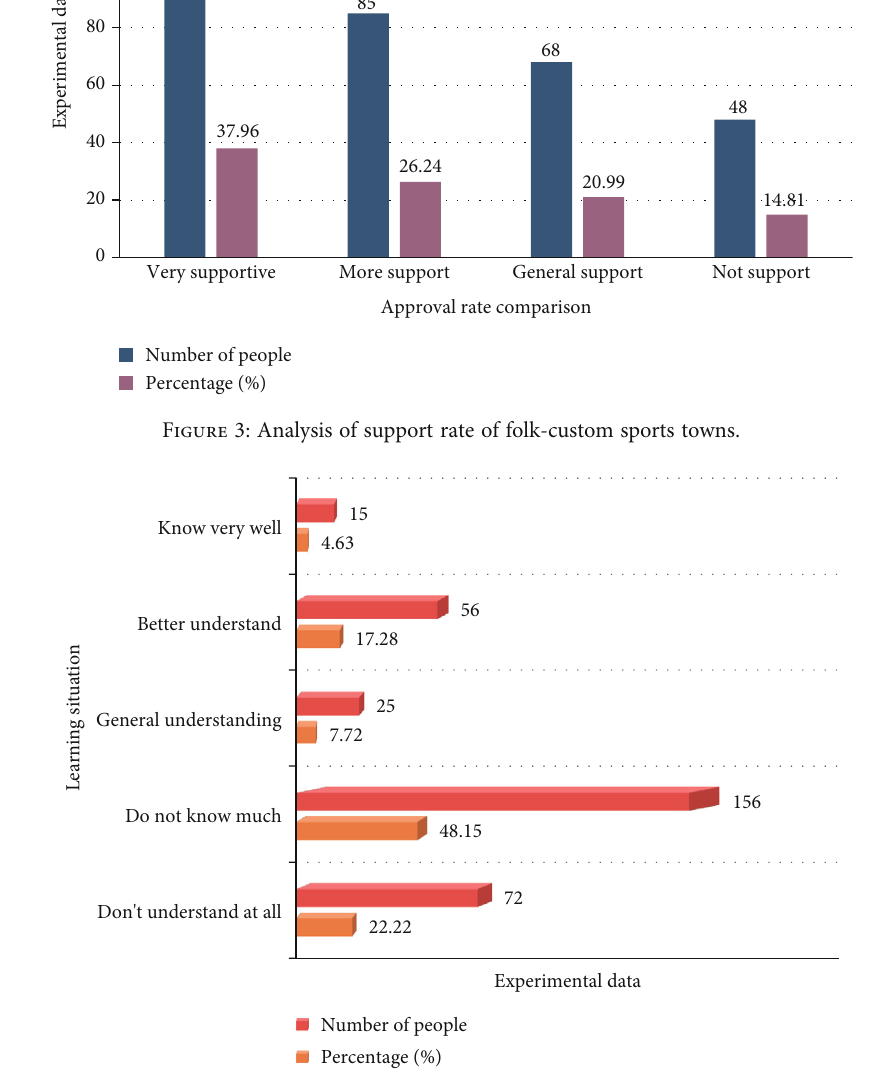
Figure 4: Analysis of the degree of understanding of intelligent building